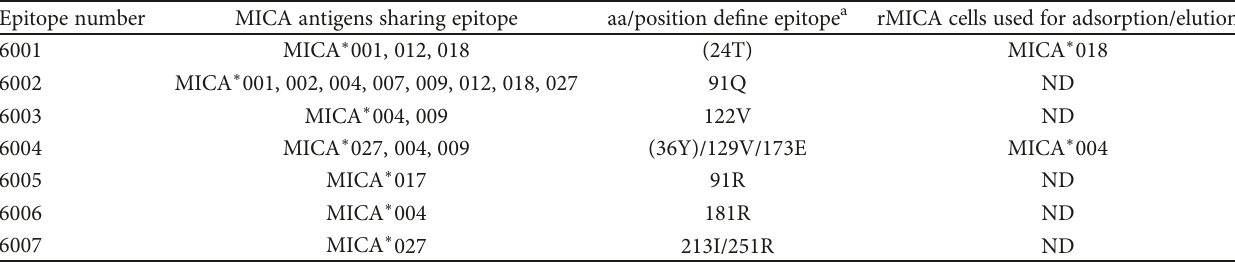
Figure 9: Epitope 5007 shared by the HLA class I A-locus antigens A31 and A33 and de fi ned by isolucine (I) at position 73. The epitope is accessible on the dissociated antigens and show stronger reactivity when the peptide has been dissociated from the heavy chain. Position 73 is not exposed in an intact HLA class I antigen. After acid bu ff er treatment and neutralization of the eluate, epitope 5007 becomes exposed and reacts with the antibody 10-fold. Table 5: MICA